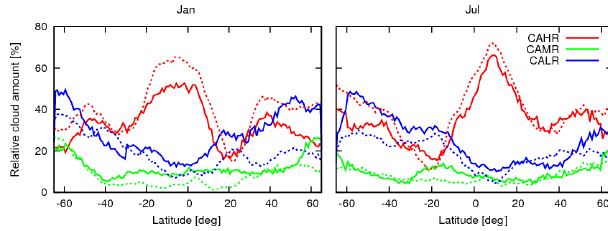
Figure 6. Latitudinal variations of monthly mean CAHR (red line), CAMR (green line), and CALR (blue line) from the slicing (solid line) and CALIPSO (dashed line) in January and